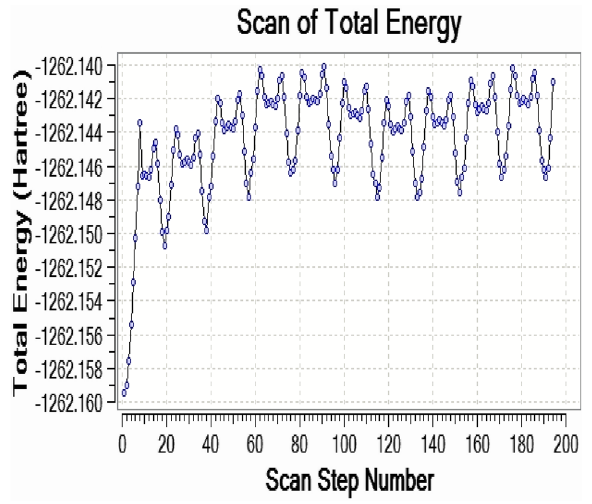
Fig. 4 Three rotor PES Scan of